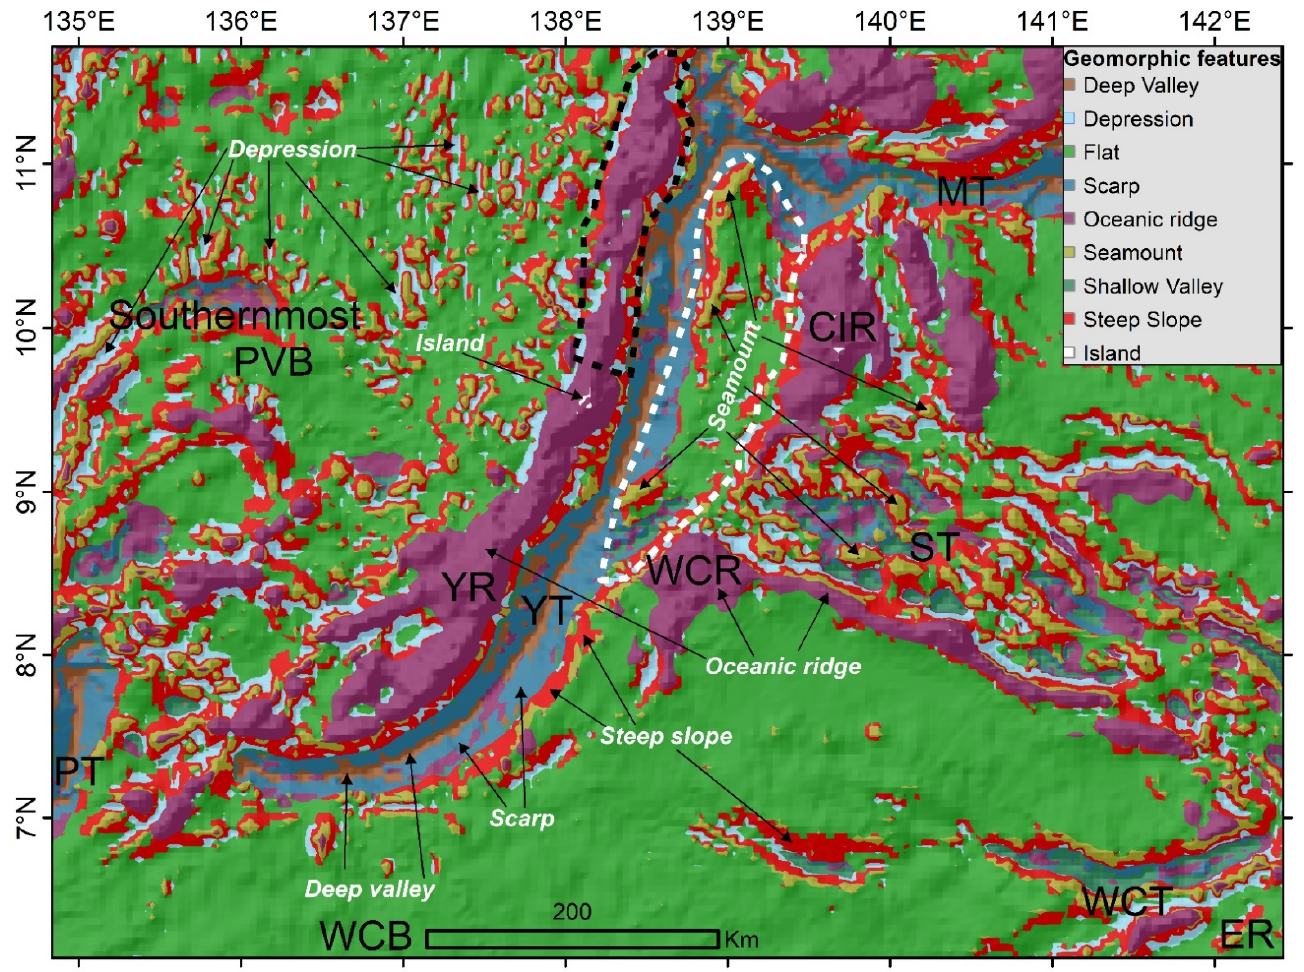
Figure 7. The classification of geomorphic features in the YSZ. The white-dashed polygon outlines the area of horsts and grabens. The black-dashed polygon delineates the region north of 10°00 ′ N of the Yap arc with unusually thinner/narrower ridge and corresponding higher Bouguer anomalies as shown in Figure 8b. The geomorphic feature “Deep valley” delineates the Mariana, Yap, and Palau trenches axes. See Figure 1 for abbreviations.